Question: Summarize what this figure shows in one sentence.
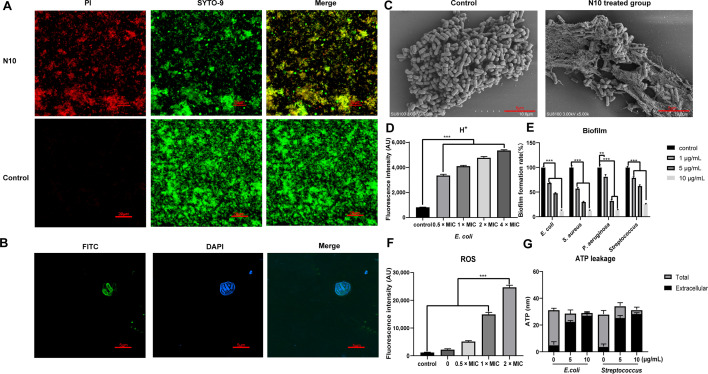
Answer: N10 damaged bacteria mainly through membrane breakage mechanisms. ( A ) Biofilm integrity measurement of E. coli cultured with peptide N10. The red fluorescence dye PI was used to stain the membranes of dead strains, and SYTO-9 was used to stain live/dead strains in the green fluorescence channel. Scale bars –20 μm. ( B ) Colocalization of FITC-labeled N10 and E. coli ATCC 25922. The bacteria were cultured with 0.5× MIC of FITC-N10 for 30 min, and the whole bacteria were stained with DAPI. Scale bars –5 μm. ( C ) E. coli morphology before and after N10 treatment via SEM. Scale bars –5 μm. ( D ) Hydrogen ion content determination. The adjusted bacteria were cultured with 0.5×, 1×, 2×, and 4× MIC of N10. An H + probe was then used to detect the H + content. ( E ) Crystal violet staining of bacterial biofilms. Biofilm formation of E. coli , S. aureus , P. aeruginosa , and Streptococcus strains cultured with 1, 5, and 10 μg/mL peptide N10. ( F ) Determination of the ROS content after infection with E. coli ATCC 25922 and treatment with different concentrations of N10 treatment. Untreated E. coli ATCC 25922 was used as control. ( G ) ATP leakage of peptide N10 treated with E. coli ATCC 25922 or S. aureus ATCC 25923. Student’s t -test was applied for statistical analysis. Data are presented as mean ± standard error of the mean, significance levels were defined as P < 0.01 (**) and P < 0.001 (***).